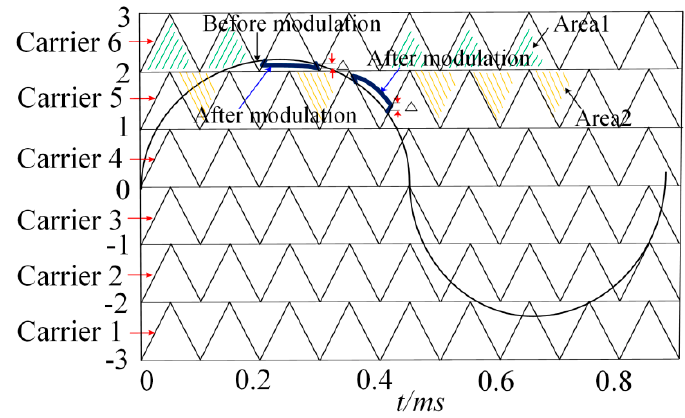
Figure 5. Unit capacitor-voltage regulator schematic.